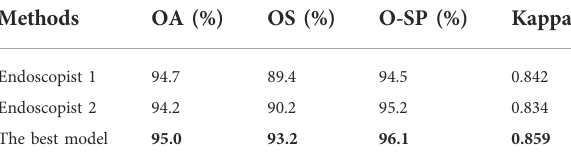
TABLE 6 Statistical comparison of two endoscopists and the best model ’ s performance in three-category classi fi cation.